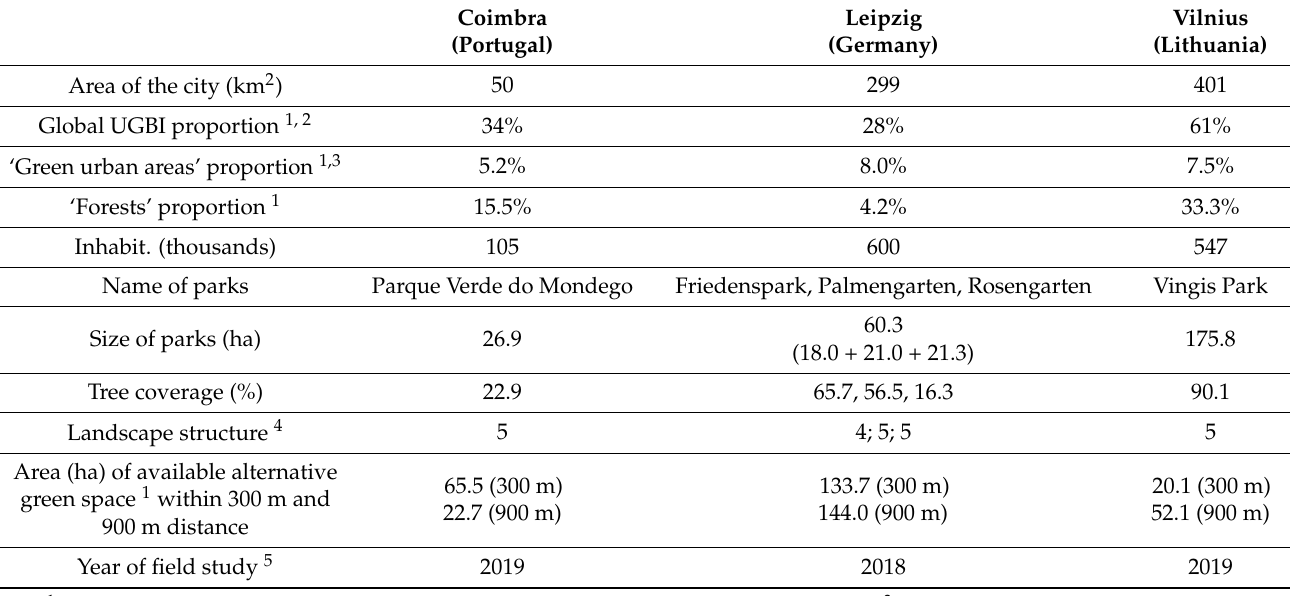
Table 1. Cities and study